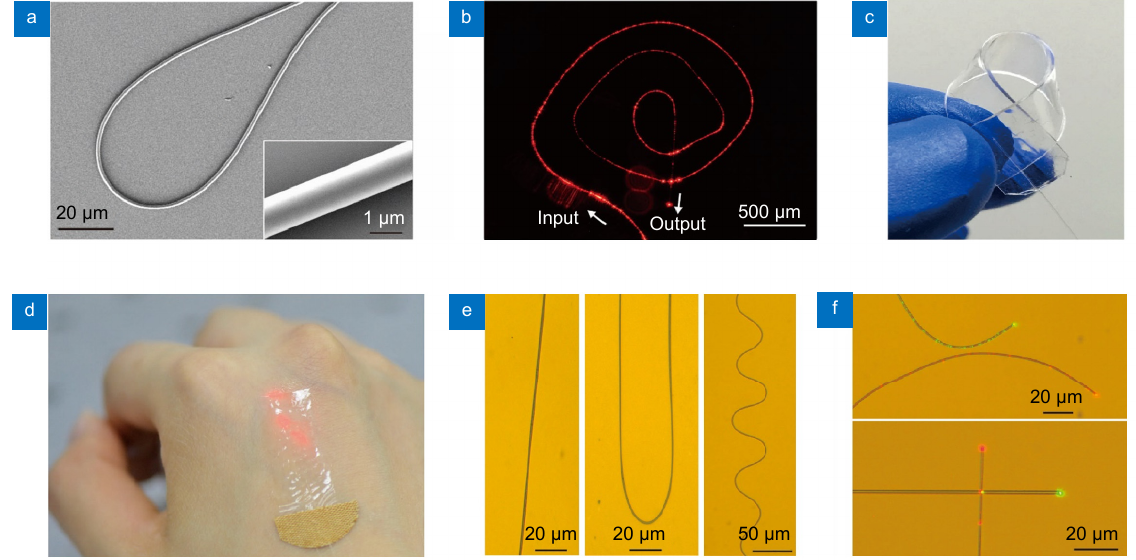
Fig. 1 | Fabrication and characterization of MNF-embedded PDMS patches. ( a ) SEM image of a 900-nm-diameter glass MNF with a bending radius of 30 μ m. Inset: close-up image of the MNF showing smooth surface and uniform diameter. ( b ) Optical microscope image of a 1- μ m-diameter glass MNF spiral guiding a 633-nm optical signal on a MgF 2 substrate. ( c ) Photograph of a bent MNF-embedded PDMS patch. ( d ) Photograph of a MNF-embedded PDMS patch attached on human hand. ( e ) Optical microscope images of three patches with straight (left), bent (middle), and wavy (right) MNFs, respectively. ( f ) Optical microscope images of two MNFs guiding 532- and 633-nm signals separately. The two MNFs are assembled into side-by-side (top) and perpendicular crossing structures (bottom), with no crosstalk